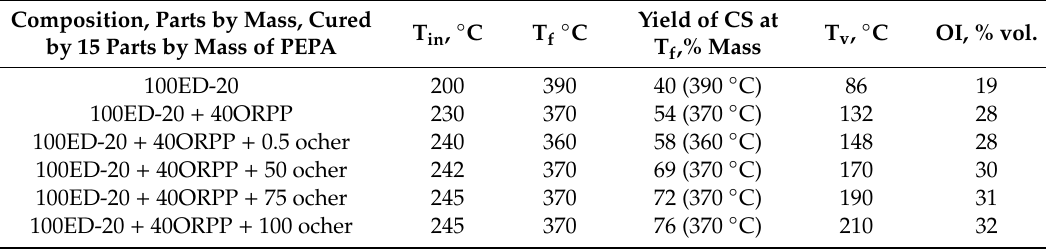
Table 4. Physico-chemical properties of epoxy composites.